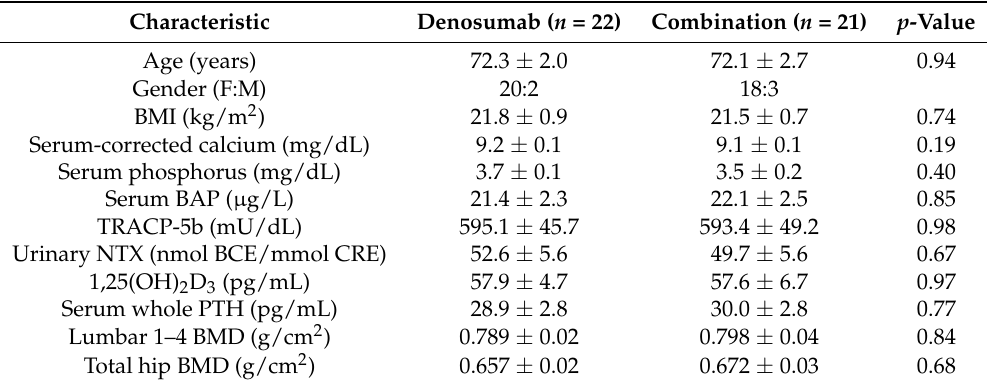
Table 1. Patient characteristics prior to denosumab